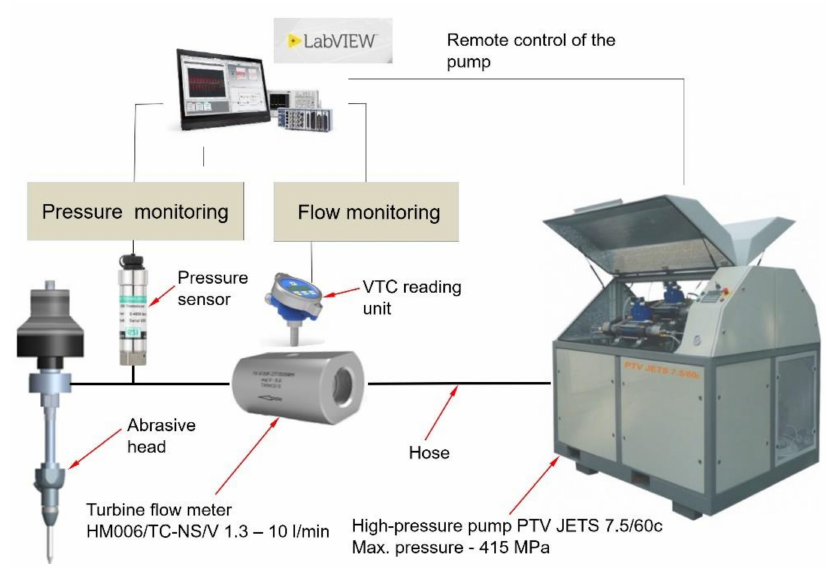
Figure 5. Experimental configuration of the flow and pressure